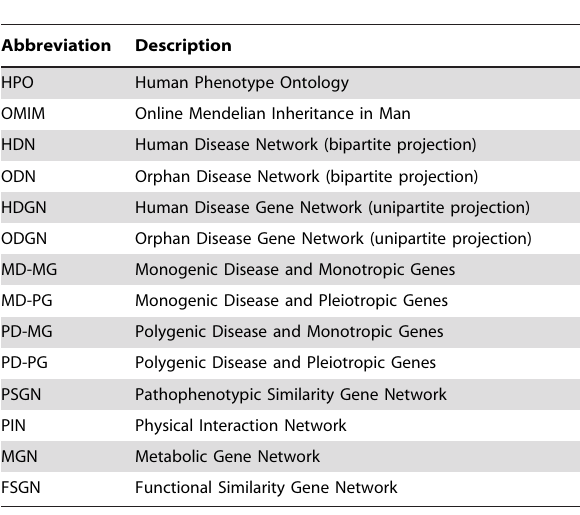
Table 1. List of abbreviations used throughout the